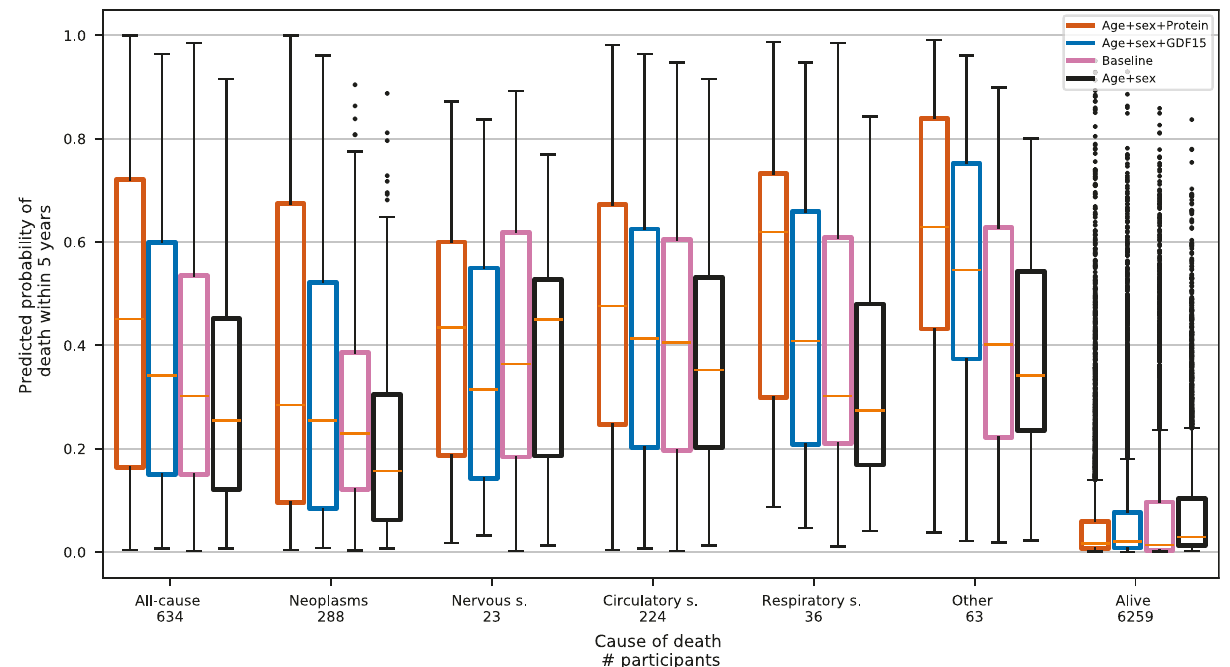
Fig. 3 Predicted risk of death within 5 years for different causes of death. Participants who died within 5 years are shown as one group and categorized by cause of death and those who were alive after 5 years are shown as one group. The yellow center line represents the median, the box limits are the upper and lower quartiles, the whiskers represent the 1.5× interquartile range, and the black dots are data points outside the whisker